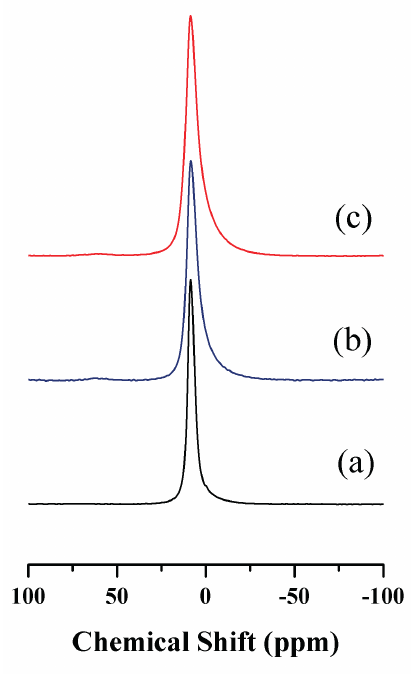
: (a) free of organic biocide, 3